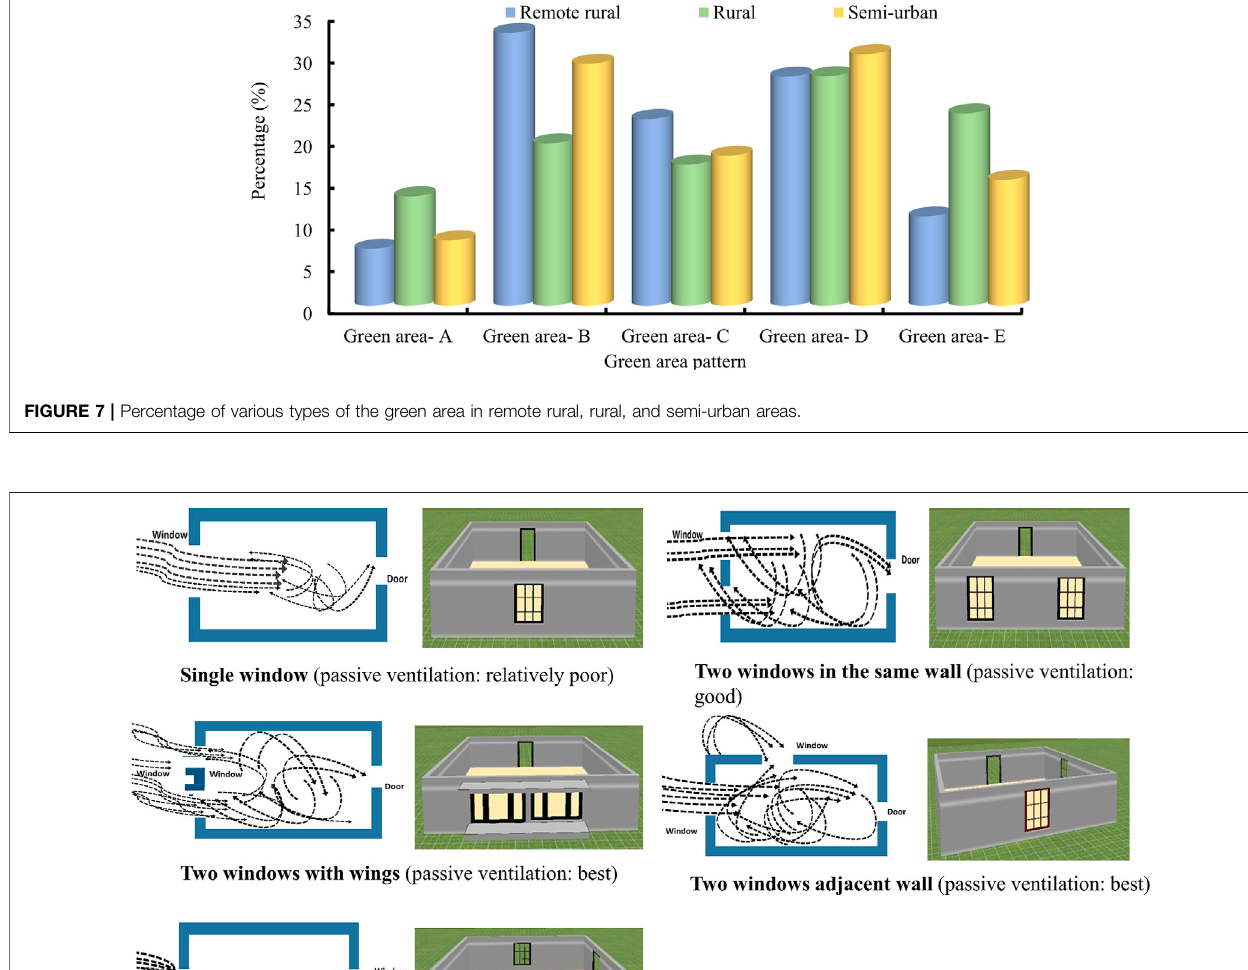
Frontiers in Built Environment |